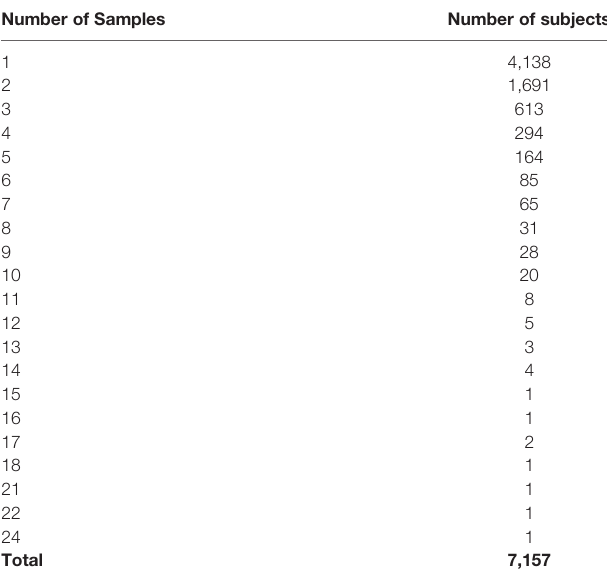
TABLE 1 | Number of blood samples per